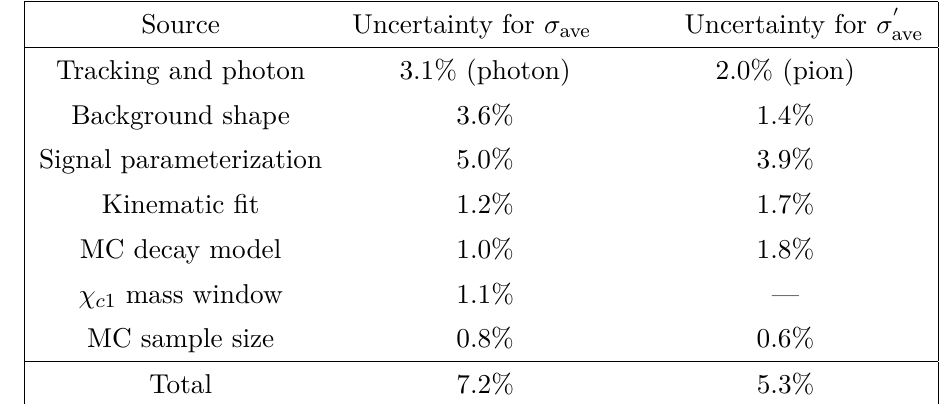
Table 3 . The systematic uncertainties for the measurement of the ratio R ≡ σ ave /σ 0 for σ 0 are quoted from ref. [10]). The “- ” means this item is not ave